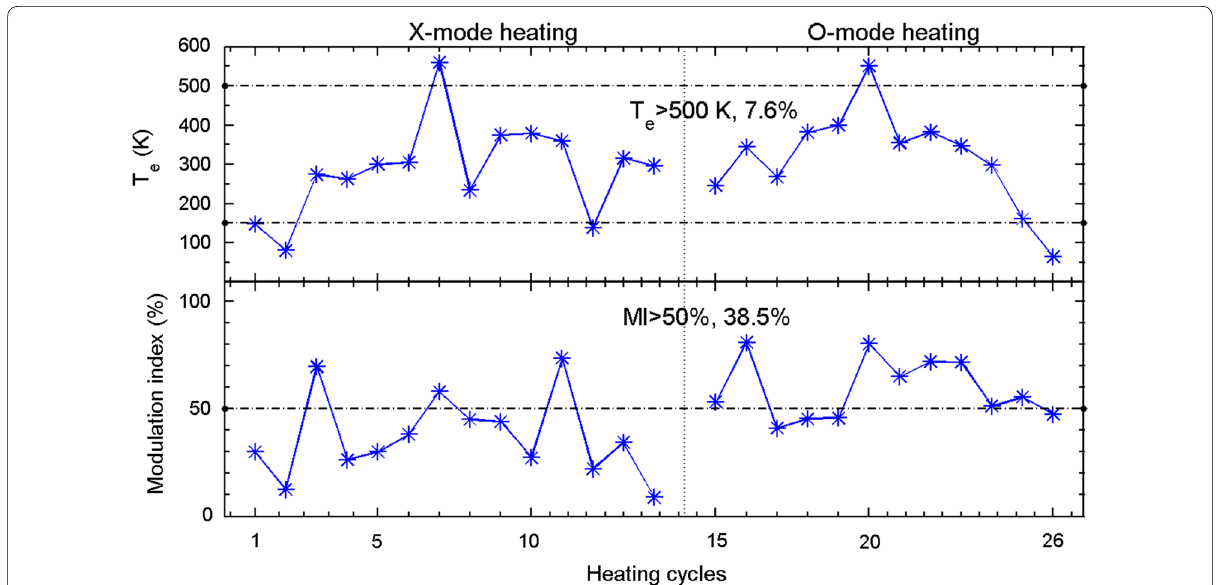
Fig. 8 As for Fig. 7 but for case 2. In this case, the HF transmitter was operated with one frequency 5.423 MHz